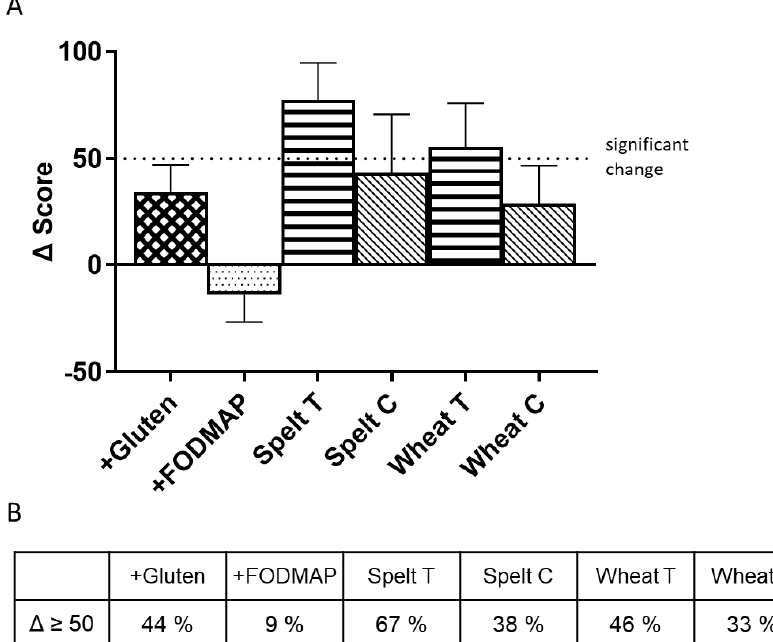
Figure 3. Total Score of Irritable Bowel Syndrome − Severity Scoring System (IBS-SSS) normalized to the previous washout phase for each individual ( A ) and percentage of participants with significantly elevated IBS-SSS total score (>50 points) ( B ). Abbreviations: FODMAP, fermentable oligo-, di-, monosaccharides and polyols; T, traditional recipe; C, current recipe. Statistics by Francis et al. (≥50 points) and Friedman/Dunn.